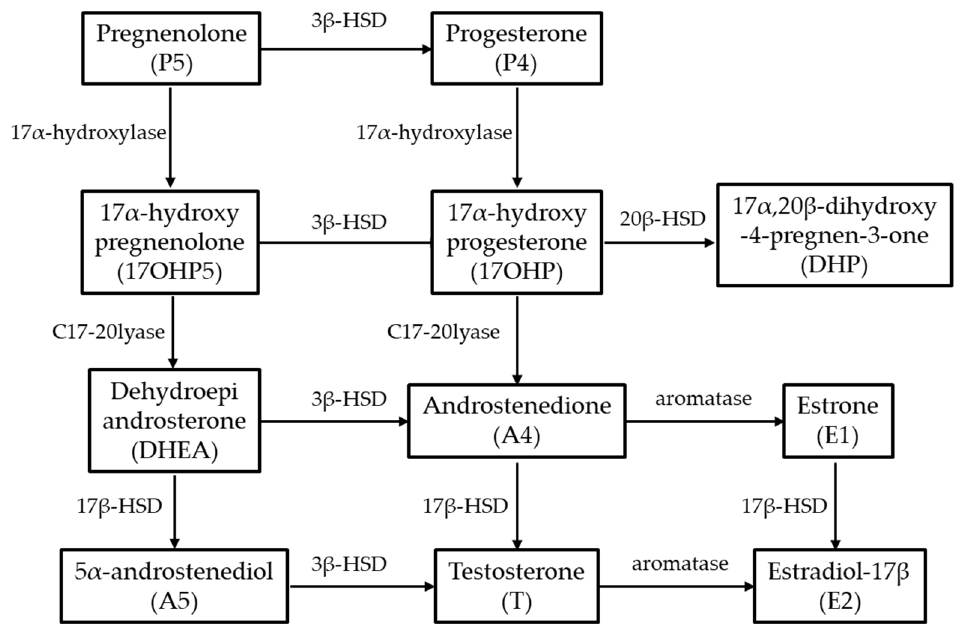
Figure 1. Steroidogenic pathway for T production. Pregnenolone, P5; progesterone, P4; 17 α -hydroxypregnenolone, 17OHP5; progesterone, P4; 17 α -Hydroxyprogesterone, 17OHP; dehydroepiandrosterone, DHEA; androstenedione, A4; 5 α -androstenediol, A5; testosterone, T. The hsd3b genes, encoding 3 β -HSD, are necessary for the production of glucocorti- coids and sex steroids [12]. In zebrafish ( Danio rerio ), hsd3b is expressed in the head kid- neys, and gonads [13]. In addition, a progressive increase in hsd3b transcripts occurs